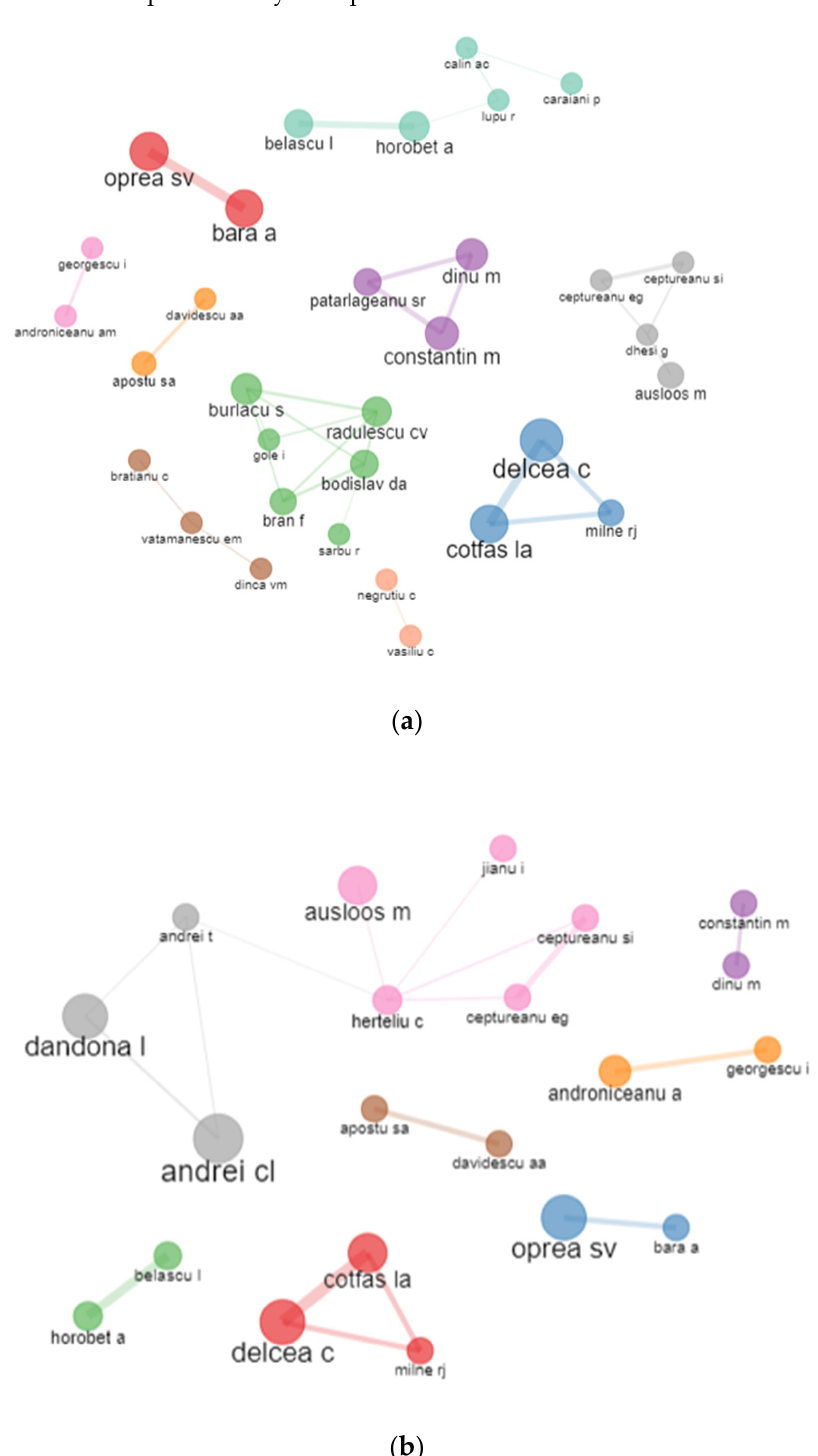
Figure 17. Authors collaboration network. ( a ) WoS. ( b ) Scopus.